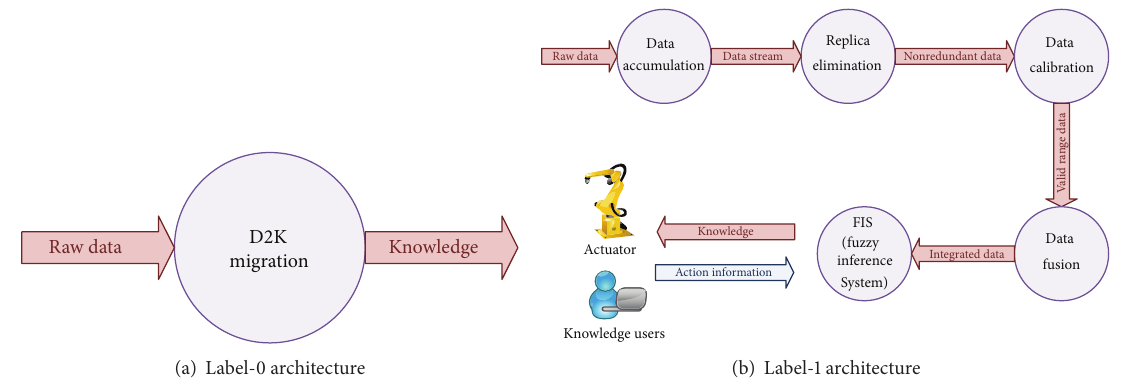
Figure 2: (a) D2K migration label-0 architecture and (b) D2K migration label-1 architecture.